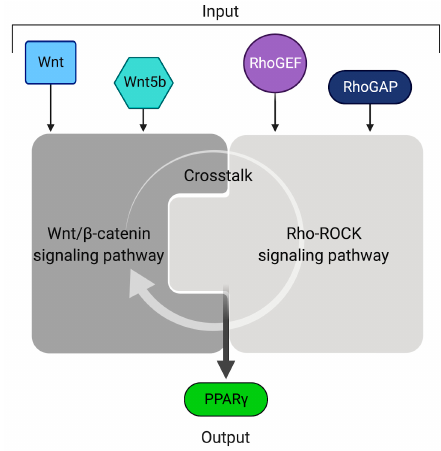
Figure 5. Schematic representation of integrative model for Wnt/ β -catenin and RhoA-ROCK pathways. Inputs are represented by species able to activate/inactivate the two pathways (Wnt and Wnt5b for canonical and noncanonical Wnt signaling, and RhoGEF and RhoGAP for the RhoA-Rho-associated protein kinase (ROCK) signaling, respectively). Different combinations of inputs will have different effects on PPAR γ expression.